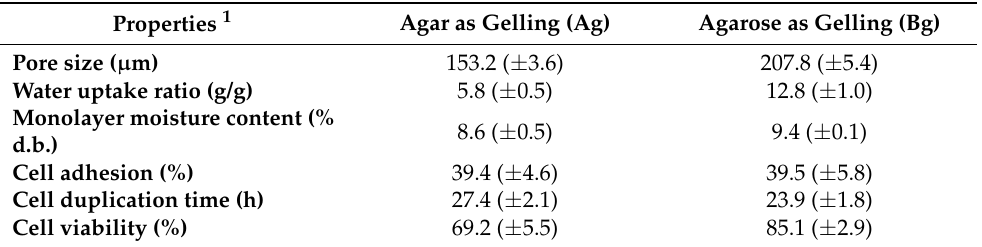
Table 2. Properties of the salmon gelatin/alginate scaffolds made with glycerol as plasticizer.